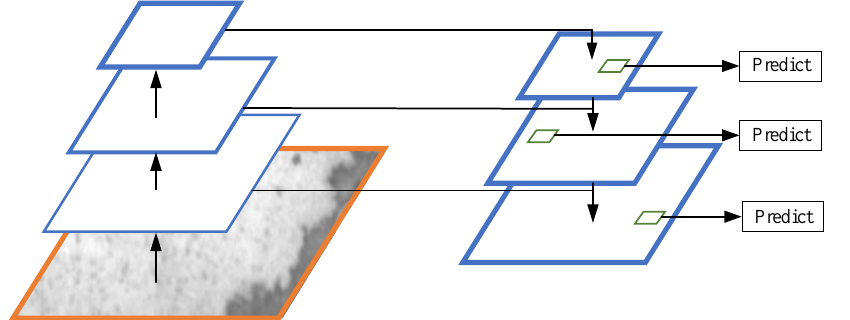
Figure 2. Feature pyramid network schematic diagram.